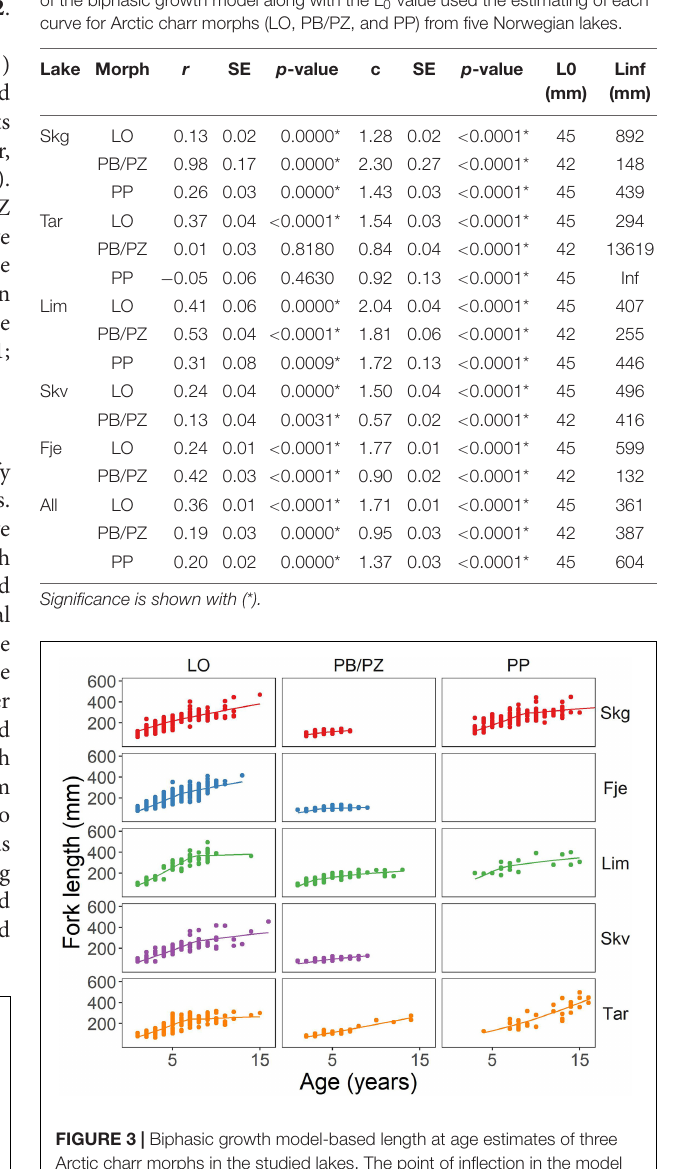
Limingen ( Tables 2 , 4 ). For the PB/PZ morph in Skogsfjordvatn, Skøvatn, and Fjellfrøsvatn no differences were found in the parameter c which ranged from 0.57 to 2.30 across all lakes ( Tables 2 , 4 ). In the PB/PZ morph the parameter r, relating to reproductive investment, ranged from 0.01 to 0.98 and was similar across most pairs while only differing between Limingen and Skogsfjordvatn, Limingen and Skøvatn, and Limingen and Tårnvatn ( Tables 2 , 4 ). Finally, the only difference in parameters in the PP morph was between Tårnvatn and Limingen for the parameter c which ranged from 0.92 to 1.43 ( Tables 2 , 4 ).